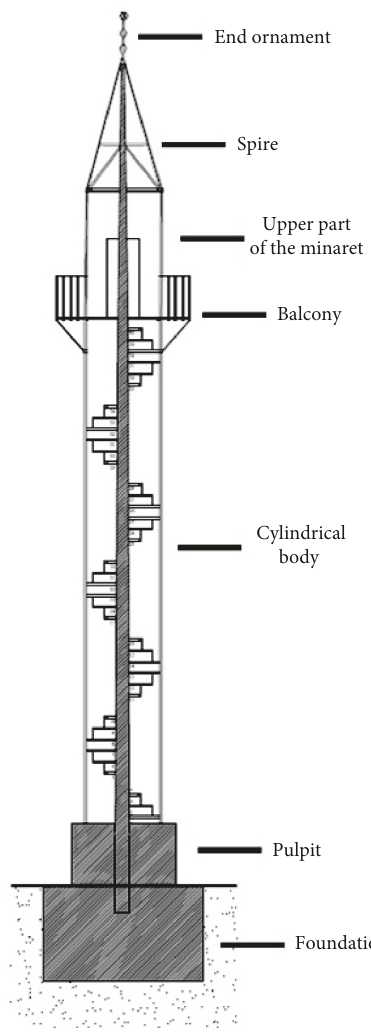
Figure 1: The sections of a timber